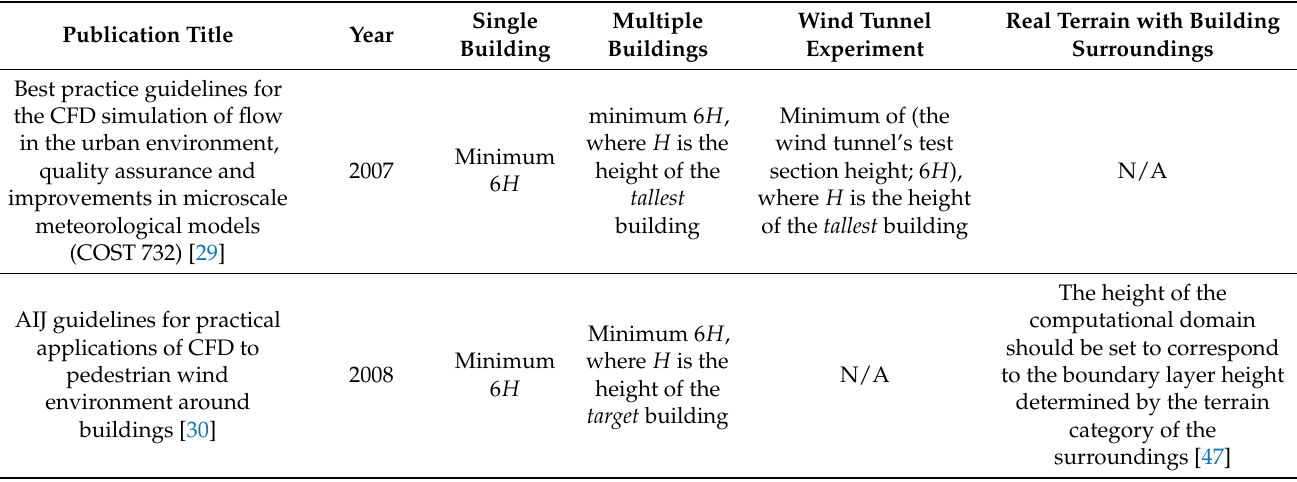
Table 3. Best practice guidelines on domain height.